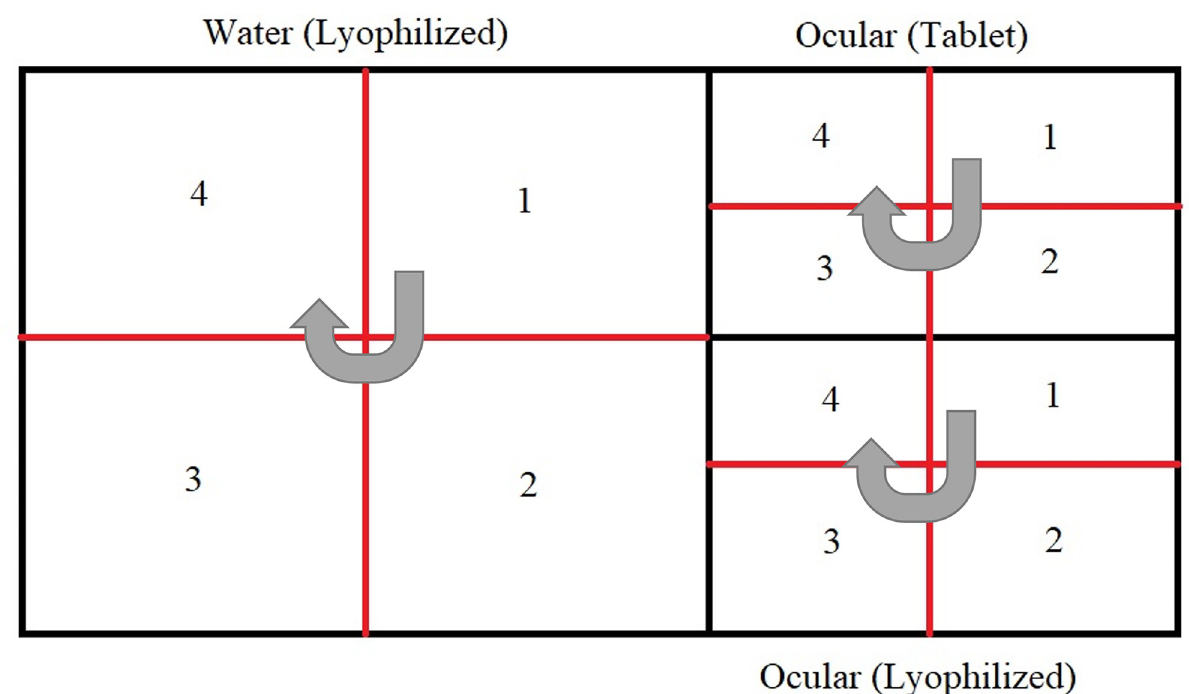
Fig 4. Physical segregation of chickens in a trial farm-water section (lyophilized, Group 1a and 1b), ocular section (Tablet & Lyophilized, Group 2a and 2b) and additional quarters. The direction of sampling starts with a selection of a random section followed by sections in the direction as indicated by the grey arrows.